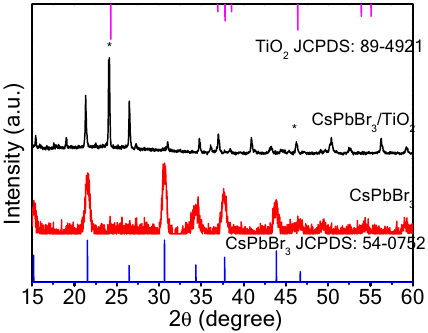
/TiO 3 2 and CsPbBr /TiO NCs. 3 3 2